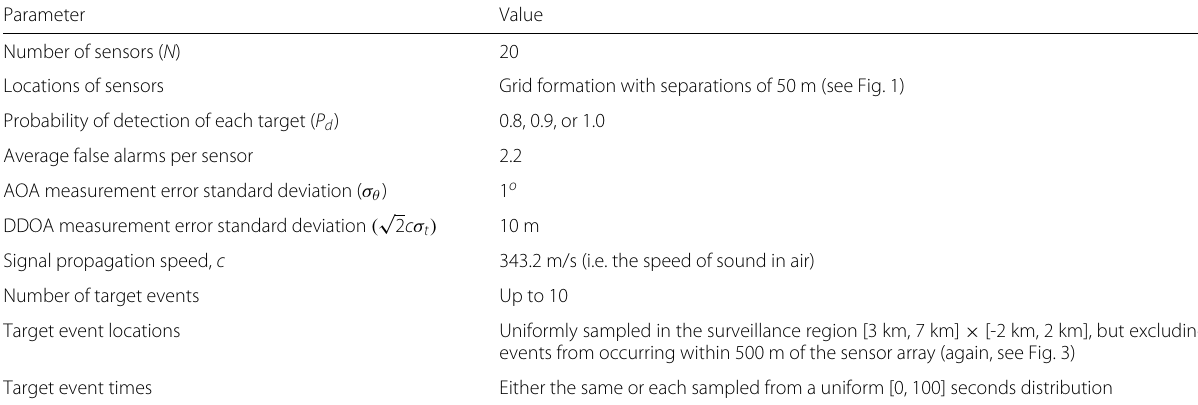
Table 1 Parameter values used in the simulations Parameter Value Number of sensors ( N ) 20 Locations of sensors Grid formation with separations of 50 m (see Fig. 1) Probability of detection of each target ( P d ) 0.8, 0.9, or 1.0 Average false alarms per